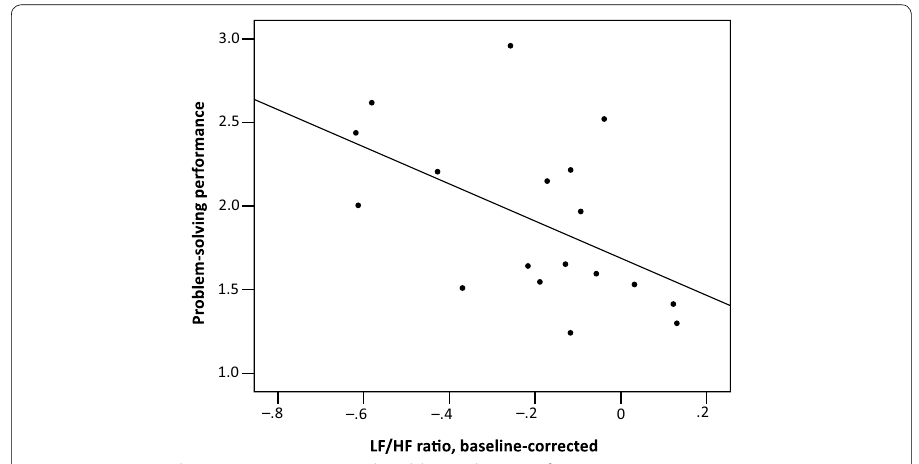
Fig. 4 Association between LF/HF ratio and problem-solving